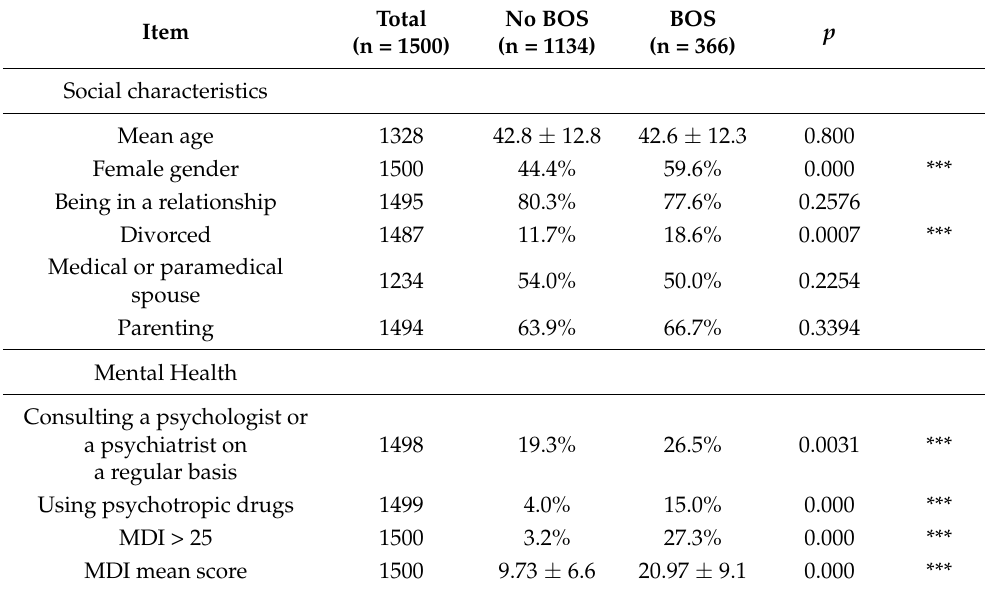
Table 2. Comparison of different items according to the main criterion regarding burnout